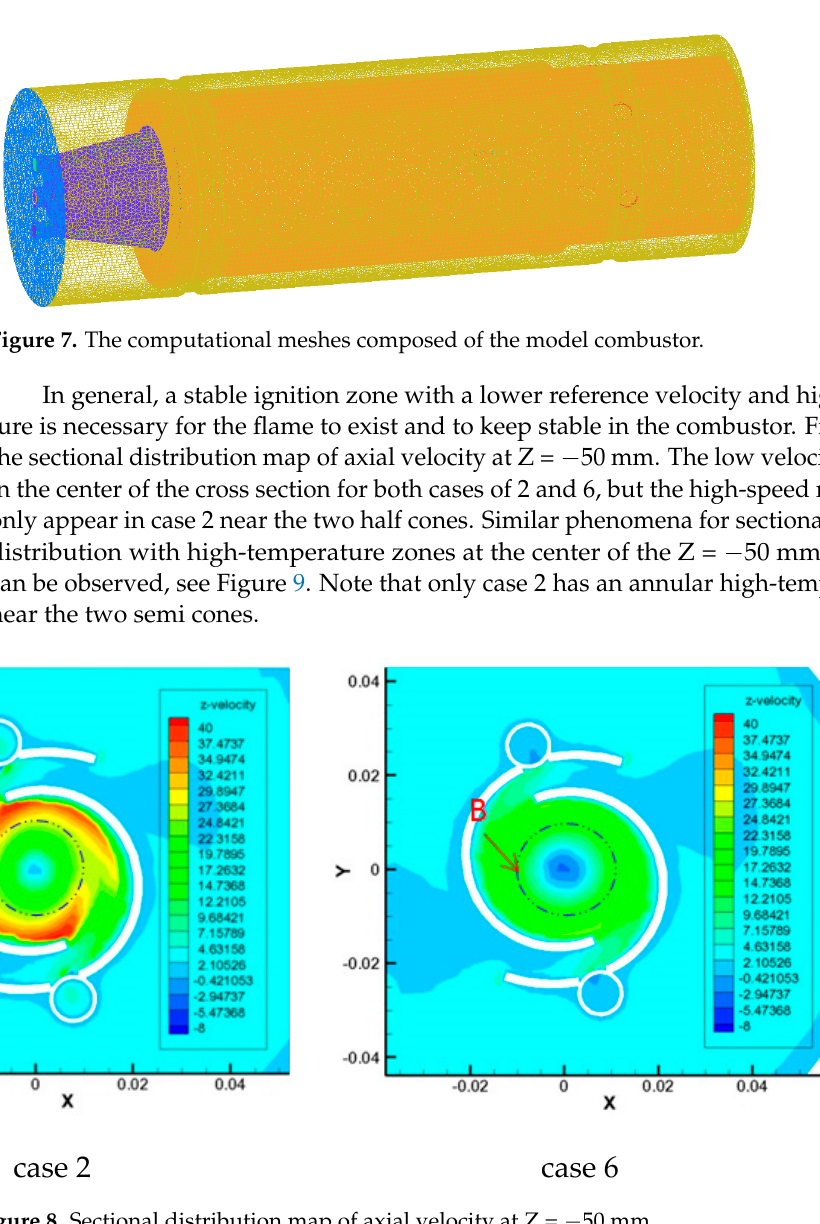
Figure 8. Sectional distribution map of axial velocity at Z = − 50 mm.